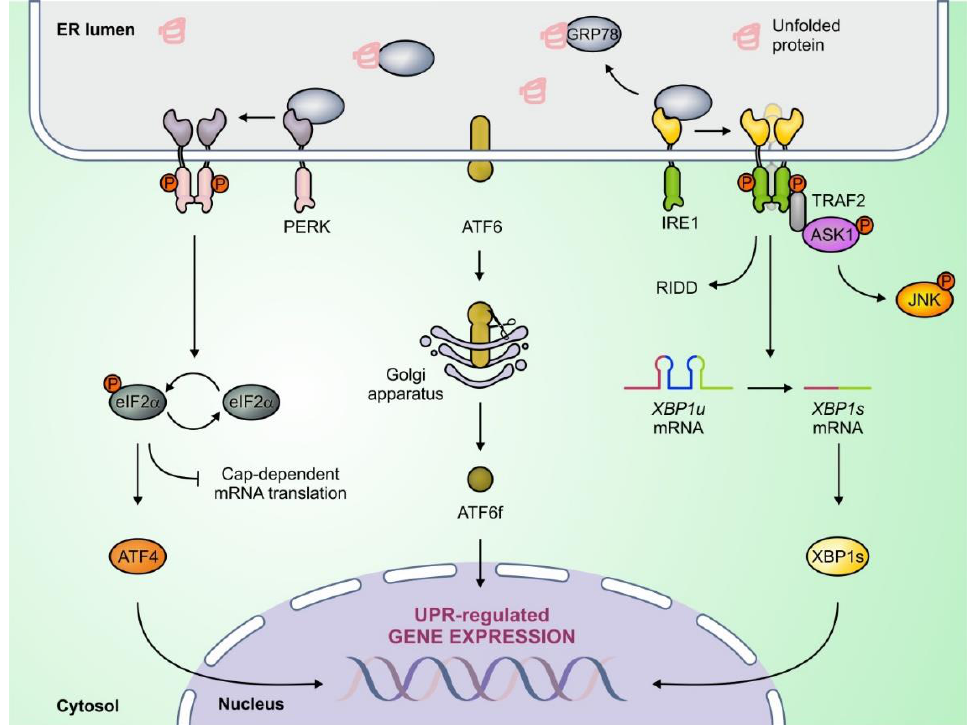
Figure 2. The unfolded protein response (UPR) is mediated by PKR-like ER kinase (PERK), activating transcription factor 6 (ATF6), and inositol-requiring enzyme 1 (IRE1) signaling. Unfolded proteins within the endoplasmic reticulum (ER) lumen lead to activation of ER stress sensors by sequestering glucose-regulated protein 78 kDa (GRP78). ATF4, ATF6f, and spliced x-box binding protein 1 (XBP1s) are adaptive transcription factors activated by the PERK, ATF6, and IRE1 signaling branches respectively, and promote expression of chaperones and protein degradation pathway components.